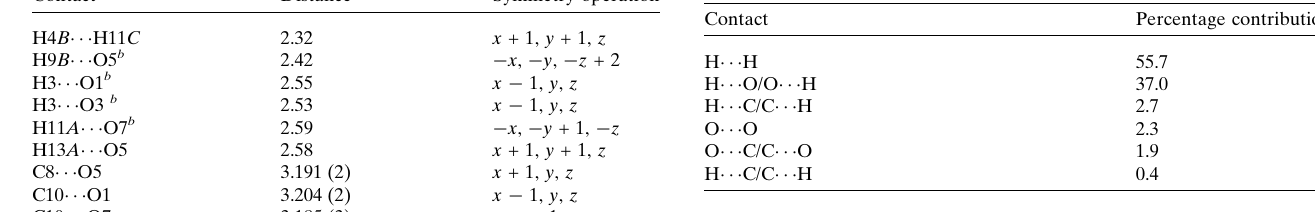
Table 3 Percentage contributions of interatomic contacts to the Hirshfeld surface for (II).